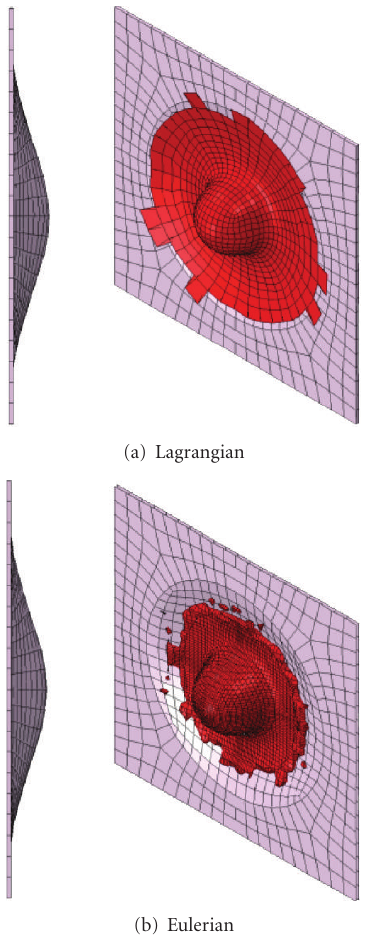
Figure 9: Validation of bird impactor models, impact on flexible metallic plate: plate